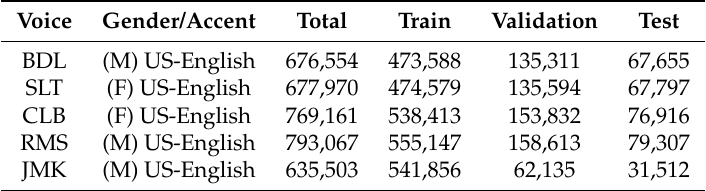
Table 1. Amount of data (vectors) available for each voice in the